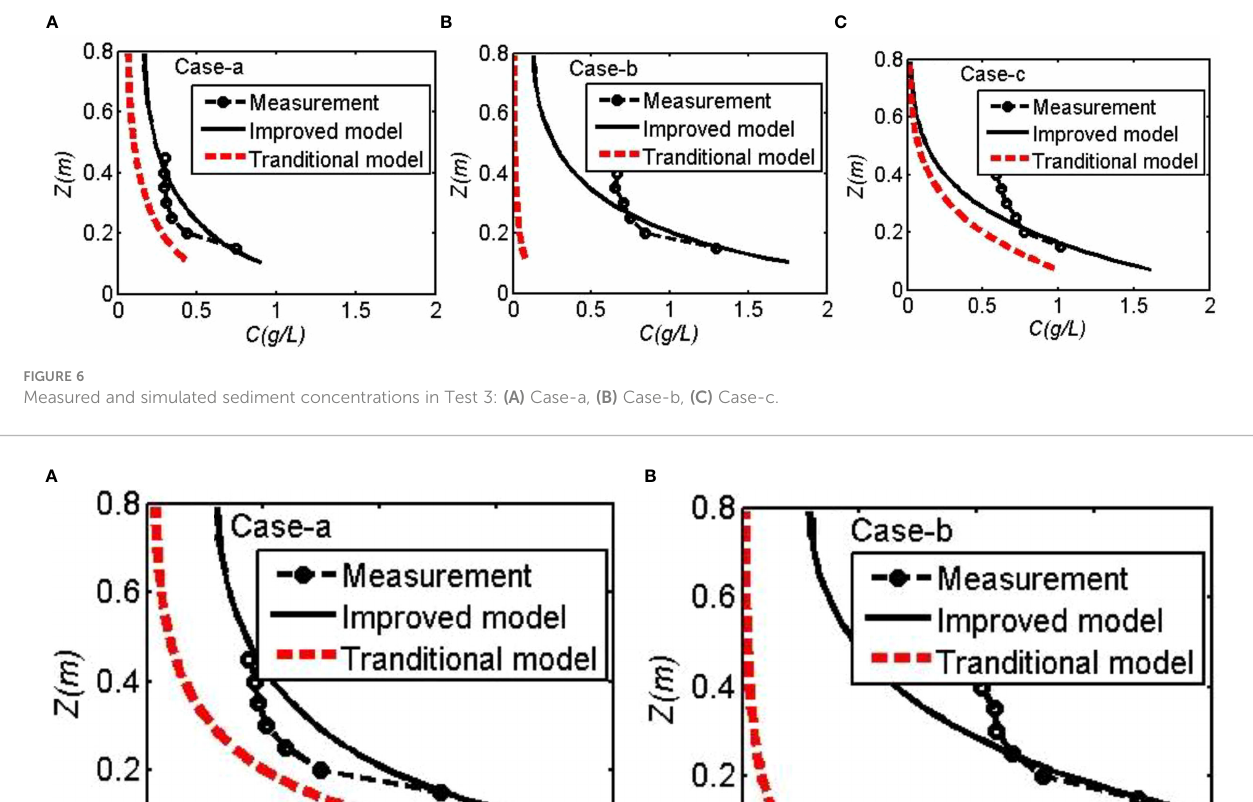
FIGURE 7 Measured and simulated sediment concentrations in Test 4: (A) Case-a, (B) Case-b.